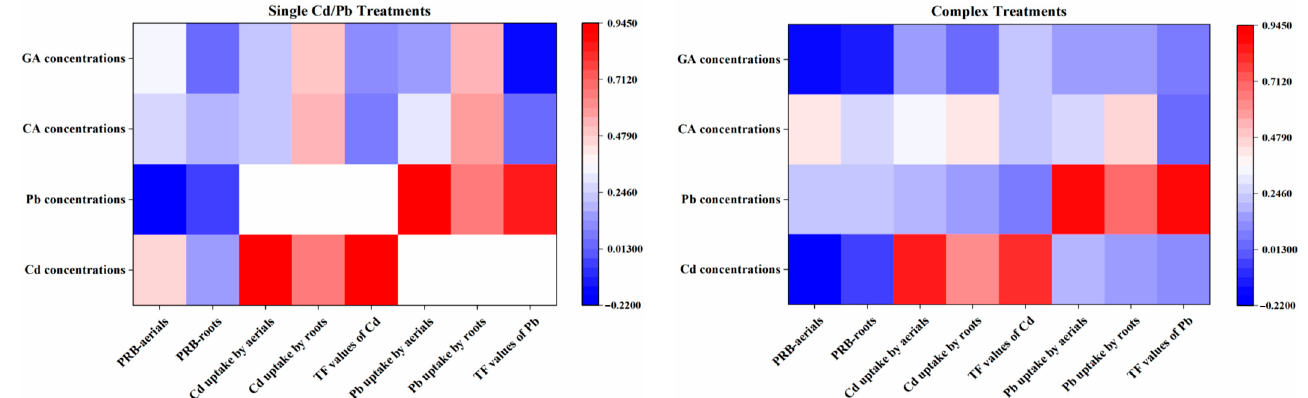
Figure 5. Correlation between concentrations of CA, GA, Cd/Pb and PRB, Cd/Pb uptake, TF of sunflower in single and complex treatments based on 180 (n) soil samples. CA, citric acid; GA, glutaric acid; PRB, promotion ratio of biomass; TF, transfer factor.